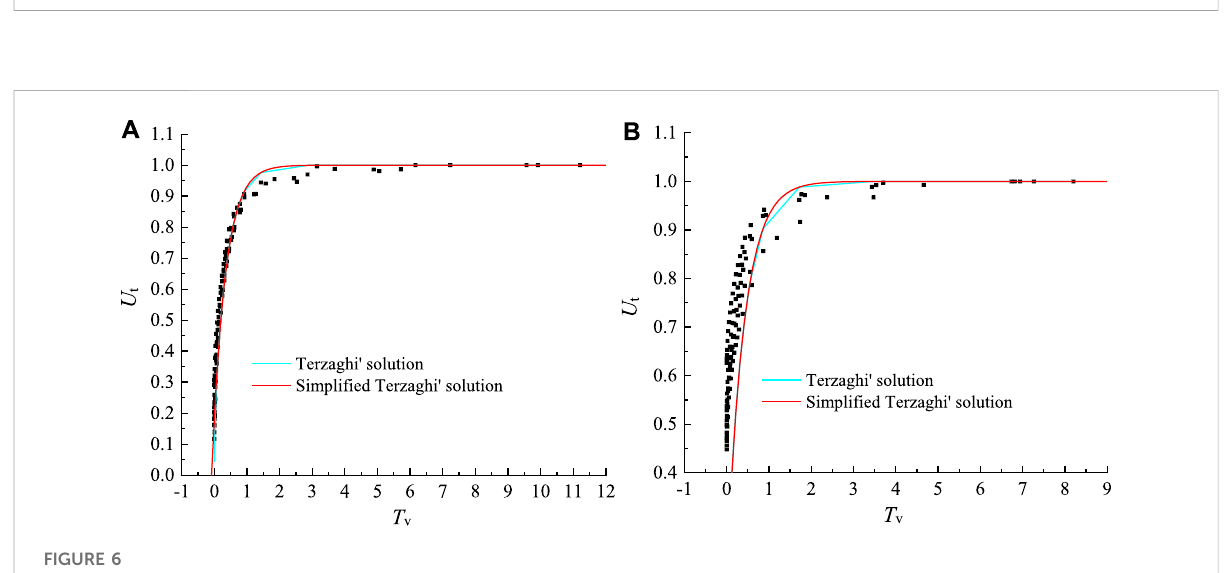
FIGURE 6 Data fi ttingofthesolutionofTerzaghi ’ s1Dconsolidationequationtoexperimentaldataforshallowclayat p =2560 kPa (A) anddeepclayat p = 20480 kPa (B)